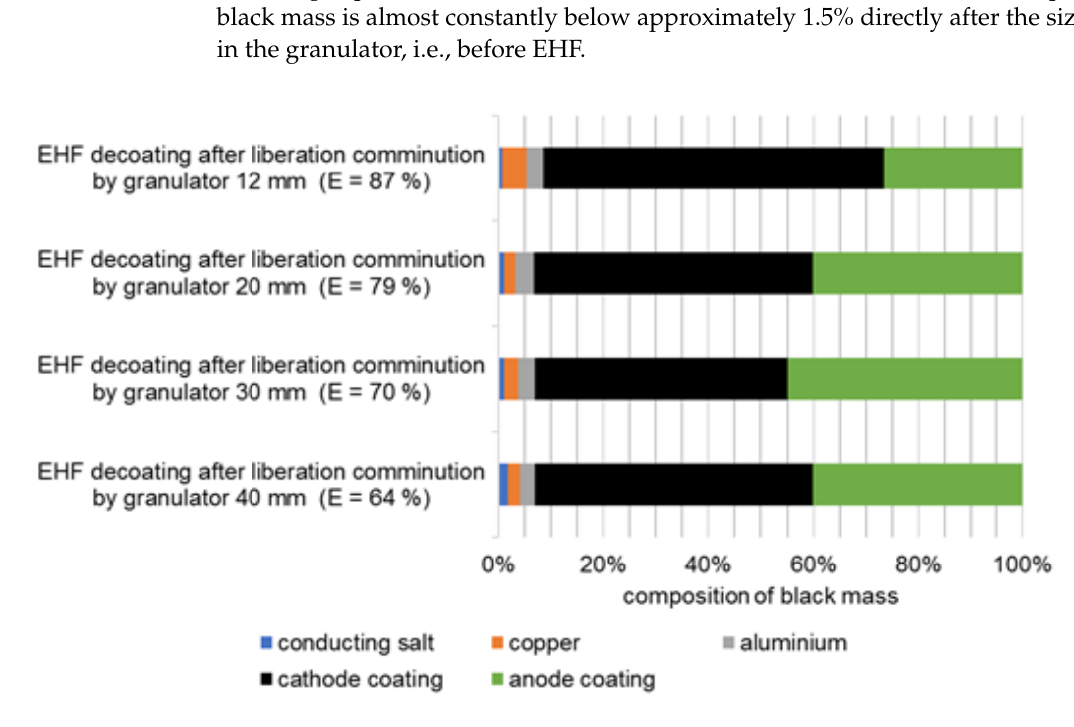
Figure 10. Composition of the black masses of cell type 1 after decoating by EHF.